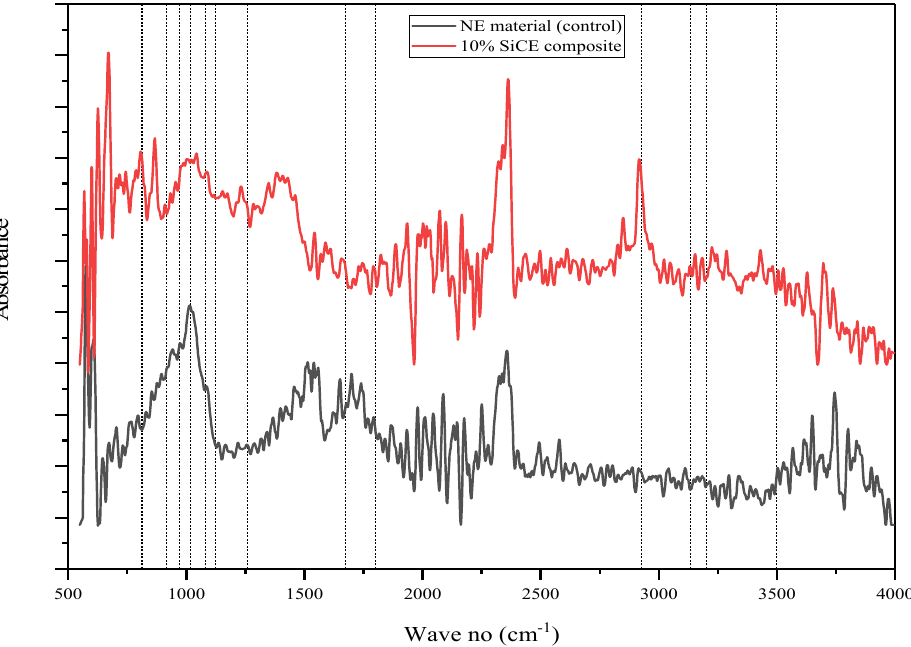
Figure 6. The r esulting FTIR spectrum of processed epoxy matrix composites. Figure 6. The resulting FTIR spectrum of processed epoxy matrix